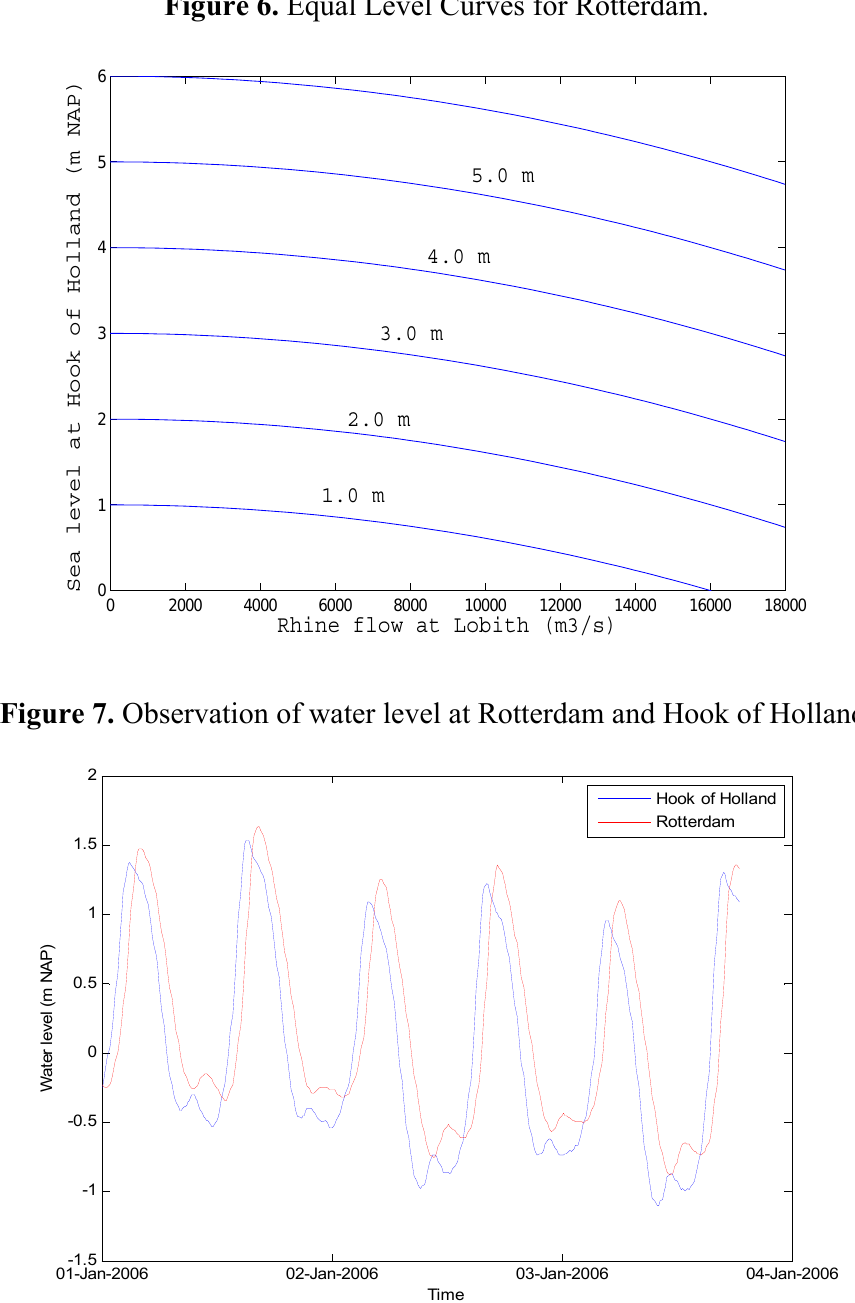
Figure 6. Equal Level Curves for Rotterdam.